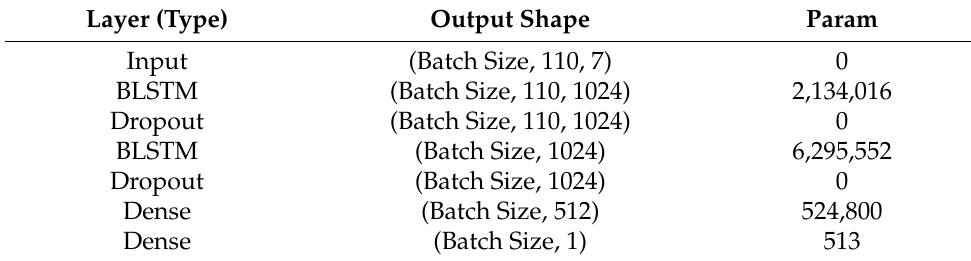
Table 5. BLSTM architecture used to predict tomato